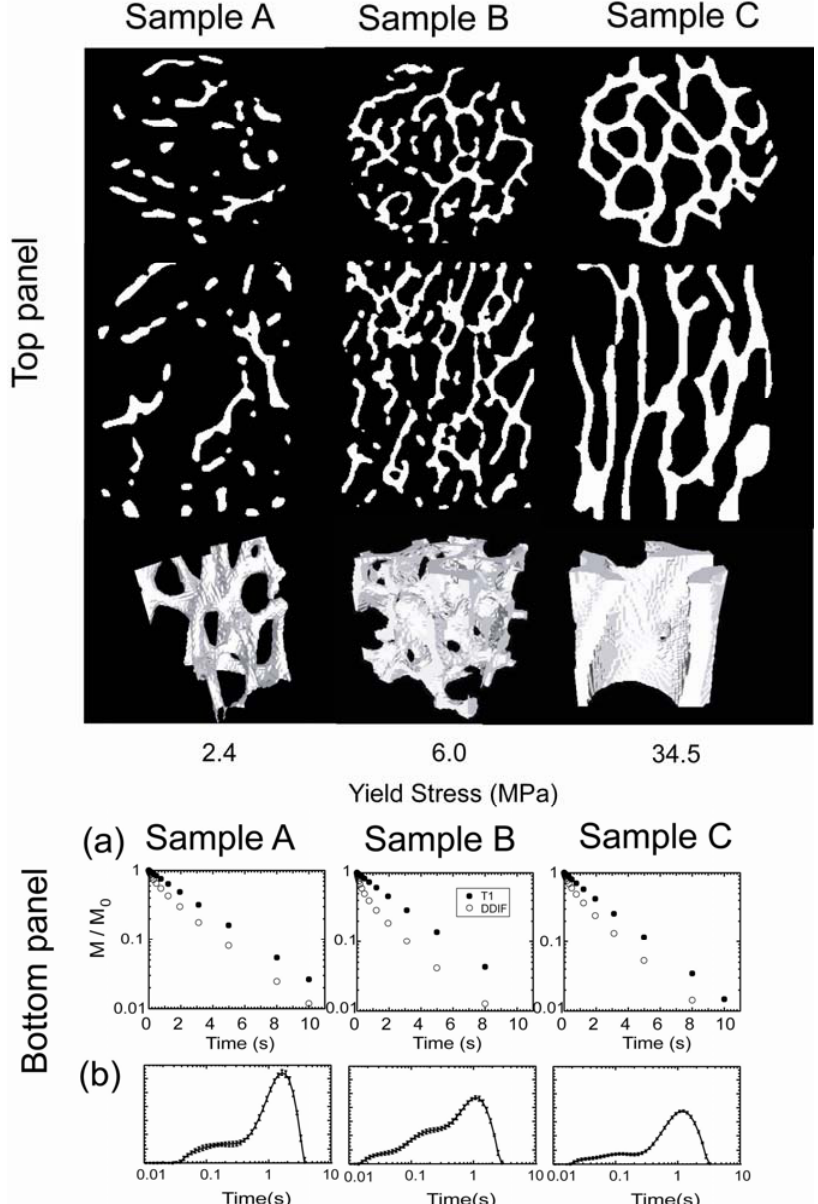
Figure 3. In the top panel, high-resolution microscopic computed tomography ( μ CT) images of 3 trabecular bone samples with different yield stresses are shown. Transverse and longitudinal slices are shown in the first and second rows, respectively. A 3D rendering of a cubical subvolume is shown in the third row. Images were acquired at an isotropic spatial resolution of 34 µm. In the bottom panel, section ( a ) shows the corresponding decay in the raw echo amplitudes as a function of the diffusion time of each sample. Section ( b ) shows the corresponding DDIF spectra obtained from Laplace inversions. Reproduced from Reference [12] with